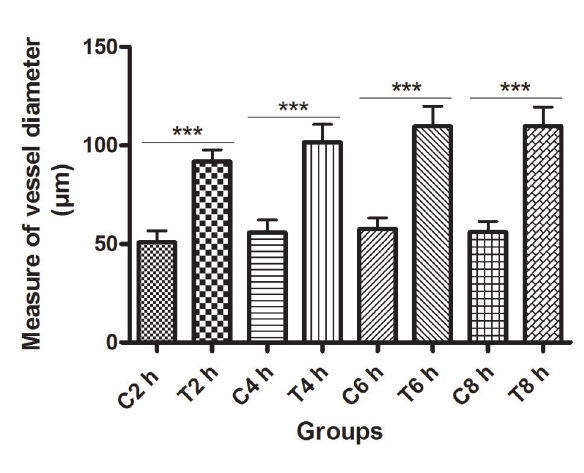
Figure 4. Diameter vessel measurement of control and experimental groups at 2, 4, 6 and 8 hours after PBS or venom injection. The difference is statistically significant (***p < 0.001/Kruscal-Wallis/Dunn’s post- test). C2h, C4h, C6h and C8h = control groups 2, 4, 6 and 8 hours after PBS injection, respectively. T2h, T4h, T6h and T8h = experimental groups 2, 4, 6 and 8 hours after venom injection, respectively.